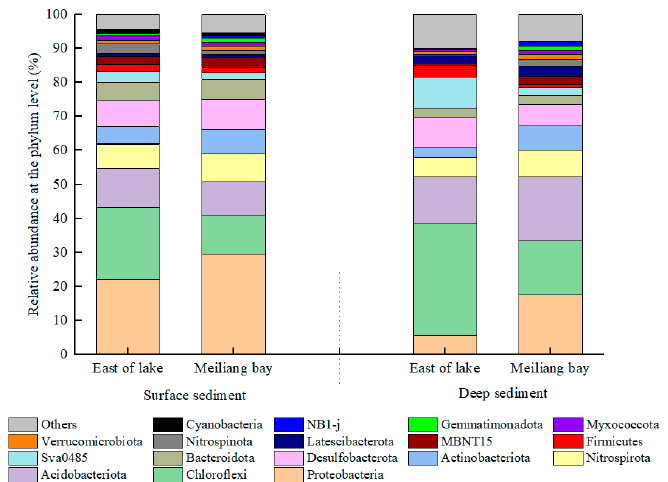
Figure 6. Taxonomic composition of bacteria in the sediments at the phylum level.